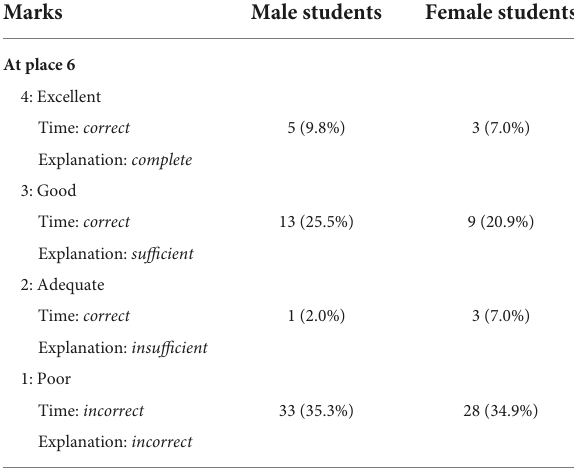
TABLE 3 Students’ marks for the suitable place questions. TABLE 4 Students’ marks for the suitable time questions.